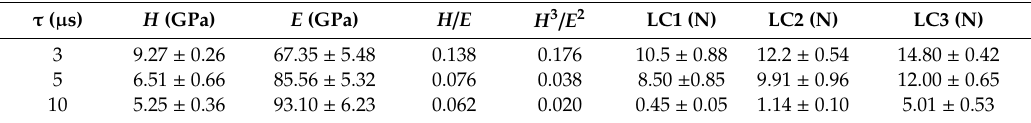
Table 1. Average values of hardness ( H ), Young ʹ s modulus ( E ), H/E and H 3 /E 2 ratios, and cohesion/adhesion critical loads (LC) for SiO 2 films deposited on silicon substrates, using different HiPIMS pulse durations.